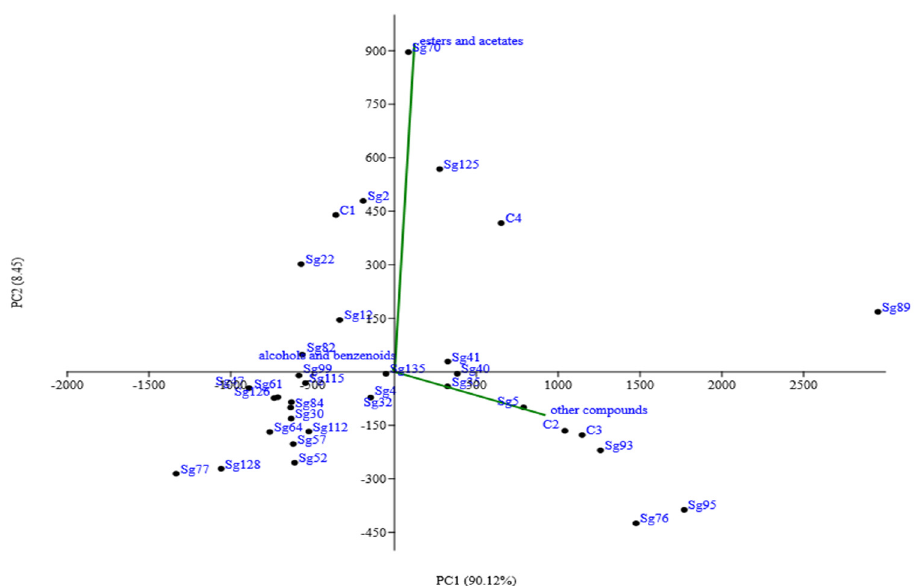
Figure 3. Principal component analysis (PCA) plot based on by-products detected in wines produced at laboratory scale with 30 different indigenous S. cerevisiae strains.